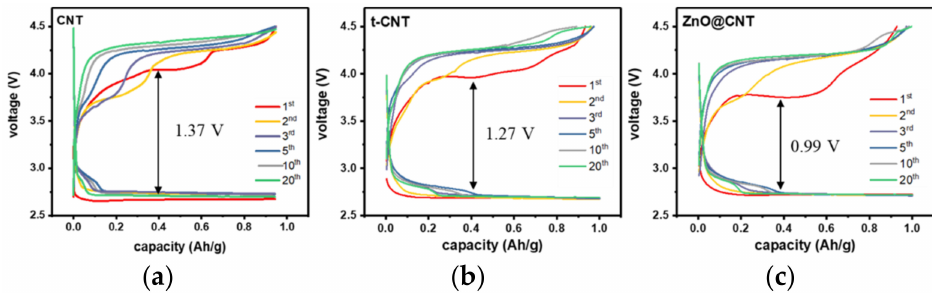
Figure 5. Discharge–charge voltage profiles at the fixed capacity of 1000 mA h g − 1 : ( a ) CNT; ( b ) t-CNT; ( c ) ZnO@CNT.